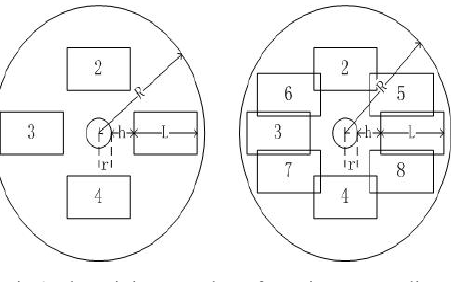
Fig 3 The minimum value of gravity zone